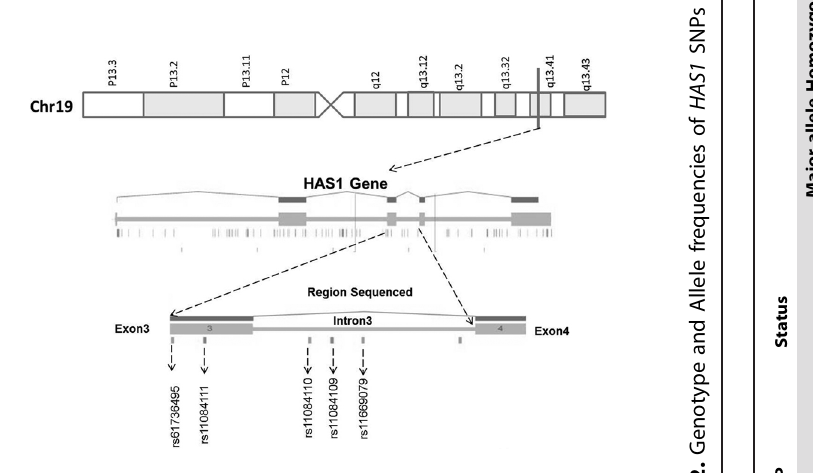
Figure 1. A schematic diagram of HAS1 gene locus in chromosome 19q13. Some parts of Figure 1 were created using Gene Window Software http://genewindow.nci.nih.gov/.